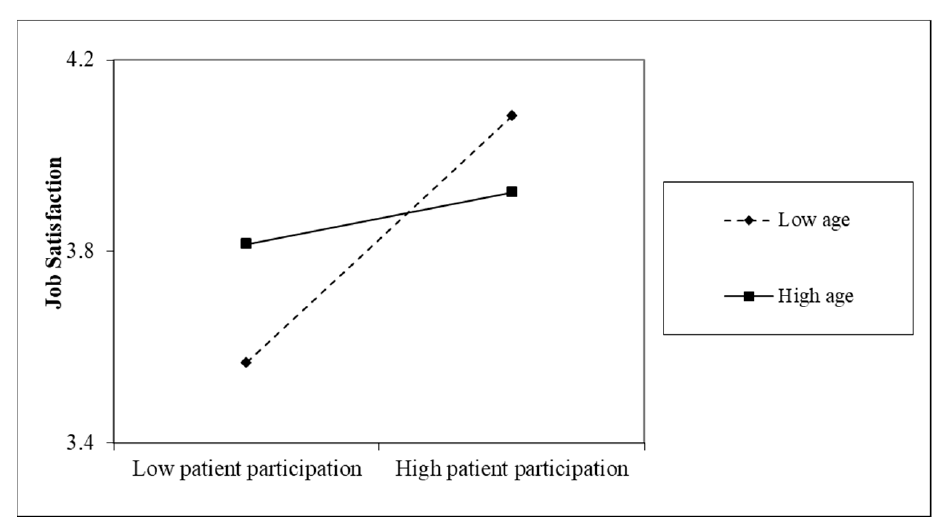
Figure 3. Simple slopes for the interaction between patient participation and age on nurse job Figure3. satisfaction.